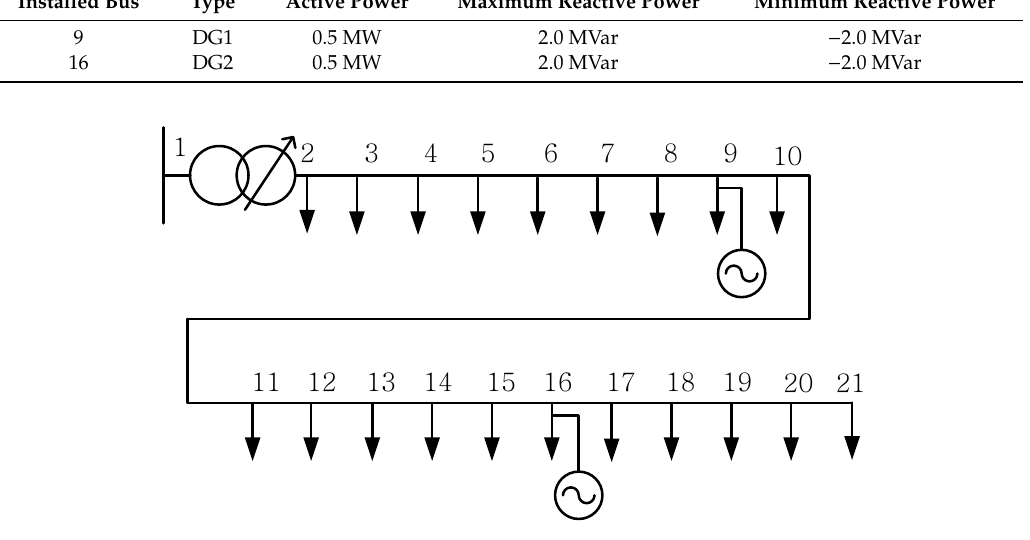
Figure 17. Single diagram of distribution network for case 1.